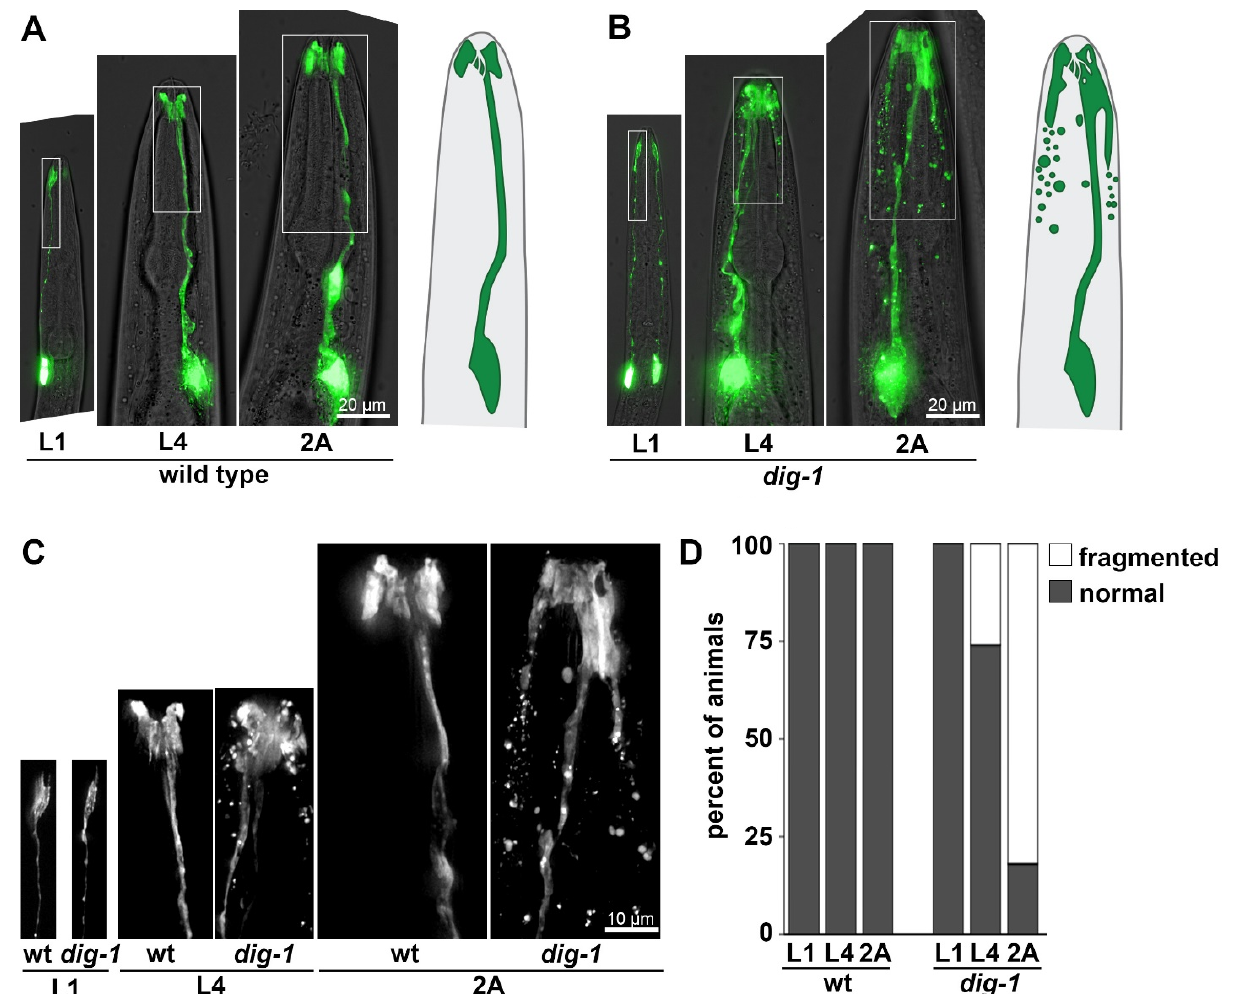
Figure 2. Amphid sheath glia undergo fragmentation in dig-1 mutants. Heads of ( A ) wild-type and ( B ) dig-1 ( n1321 ) animals at the L1, L4, and 2A stages, showing progressive fragmentation of amphid sheath in L4 and 2A dig-1 animals. Animals express F16F9.3 pro:mCherry, pseudocolored green. Schematics of amphid sheath glia are shown on the right. ( C ) 2 × magnification